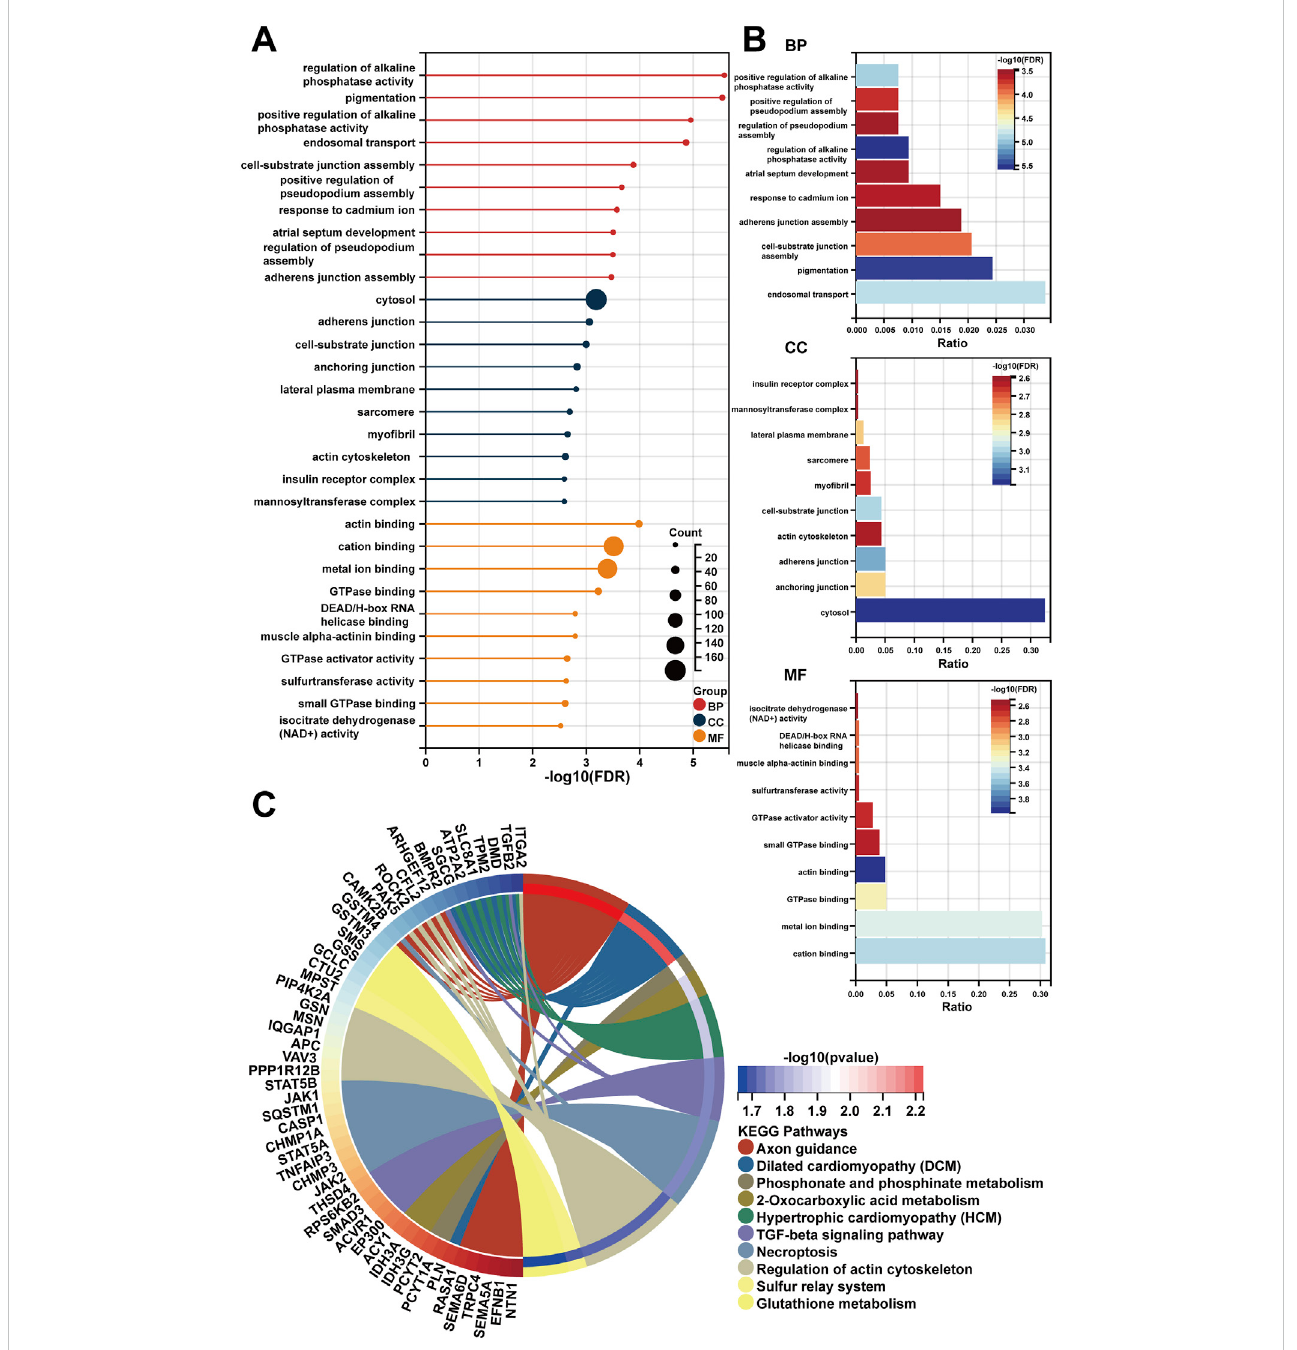
FIGURE 6 Thefunctionalenrichmentanalysisof628mRNAsintheceRNAnetwork. (A,B) Thediagramsshow thetop10termsinthreeparts(BP,CC,andMF)ofthe GO analysis. (C) The top 10 pathways in the KEGG